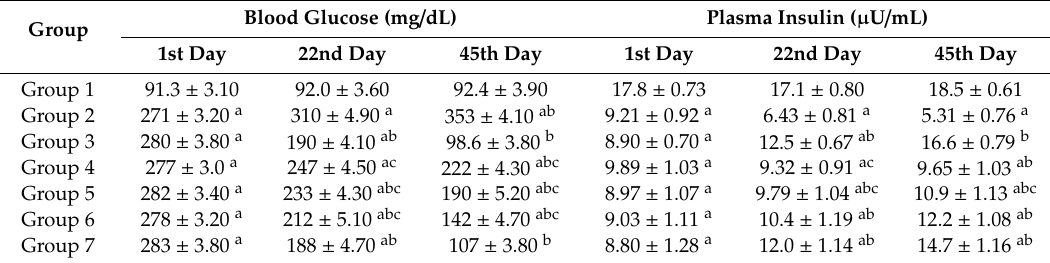
Table 3. E ff ect of methanolic extract of Punica granatum leaves (100, 200, 400, and 600 mg / kg; Groups 4–7) on blood glucose and plasma insulin levels in nicotinamide / streptozotocin-induced type 2